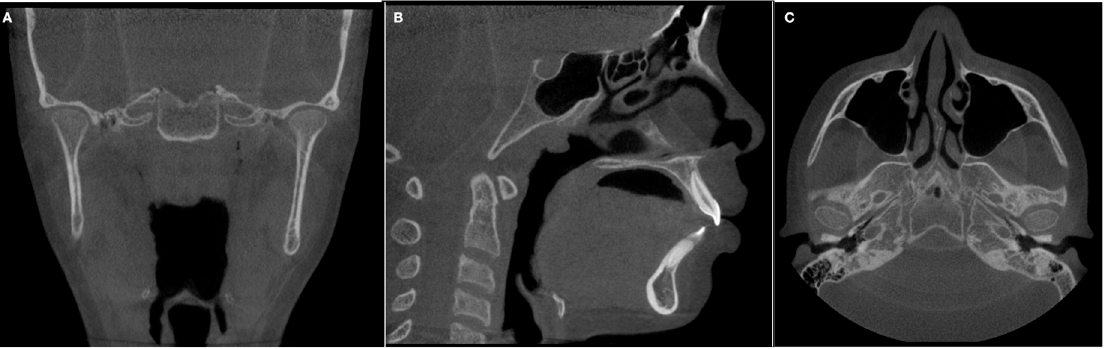
Figure 2. CBCT from a patient with no asymmetry (non-asymmetric group). ( A ) Coronal view. ( B ) Sagittal view. ( C ) Axial view.